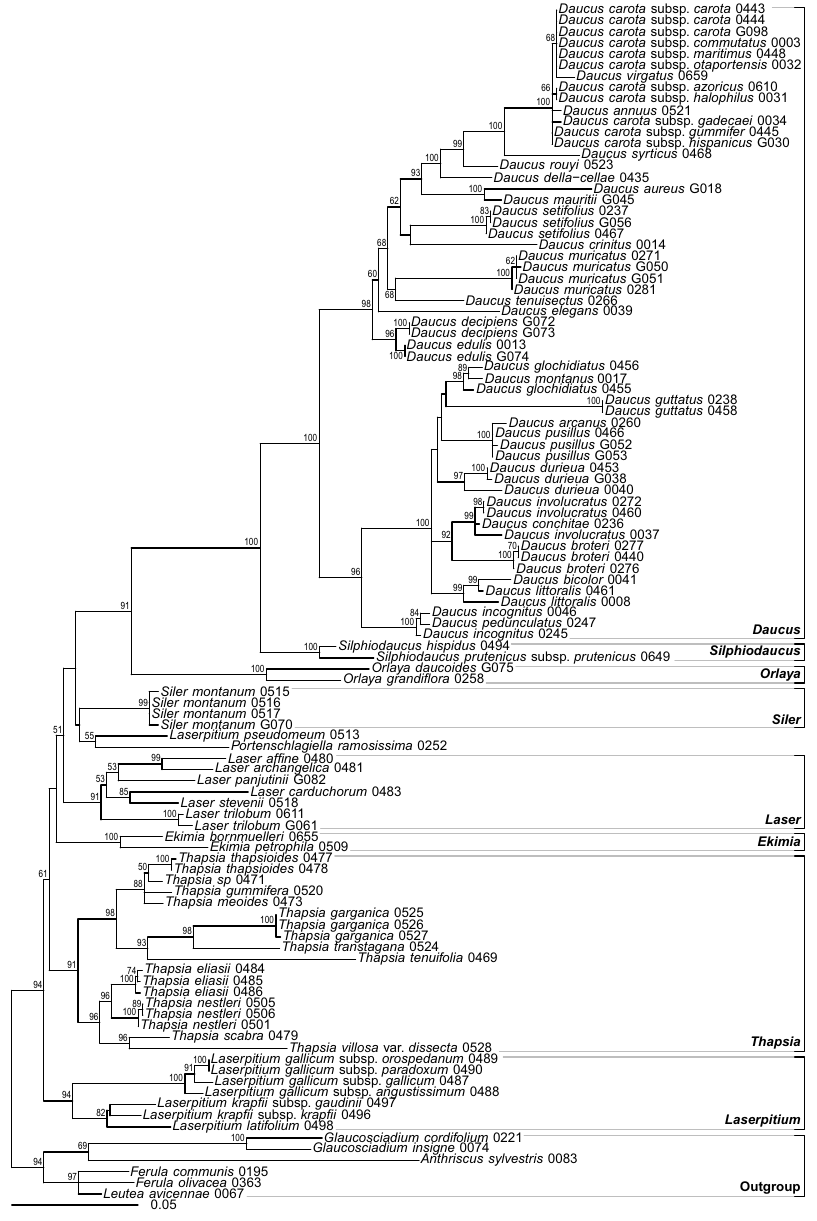
Fig. 1 Maximum likelihood tree inferred from analyses of nrDNA ITS sequences of Apiaceae subtribe Daucinae and outgroups. Bootstrap support values based on 1,000 replicates are given along the branches. Genera of Daucinae recognized by Banasiak et al. [7] are